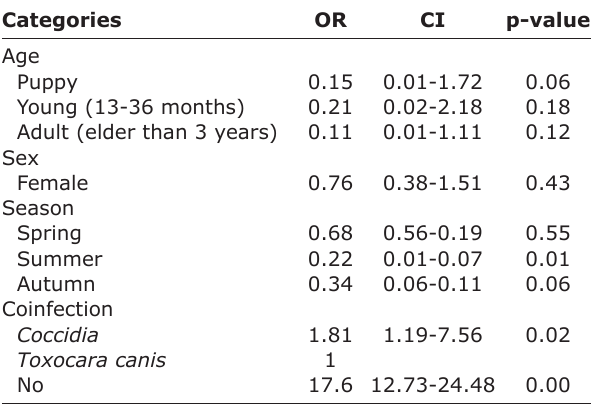
Table-2: Results of bivariate regression analysis. Categories